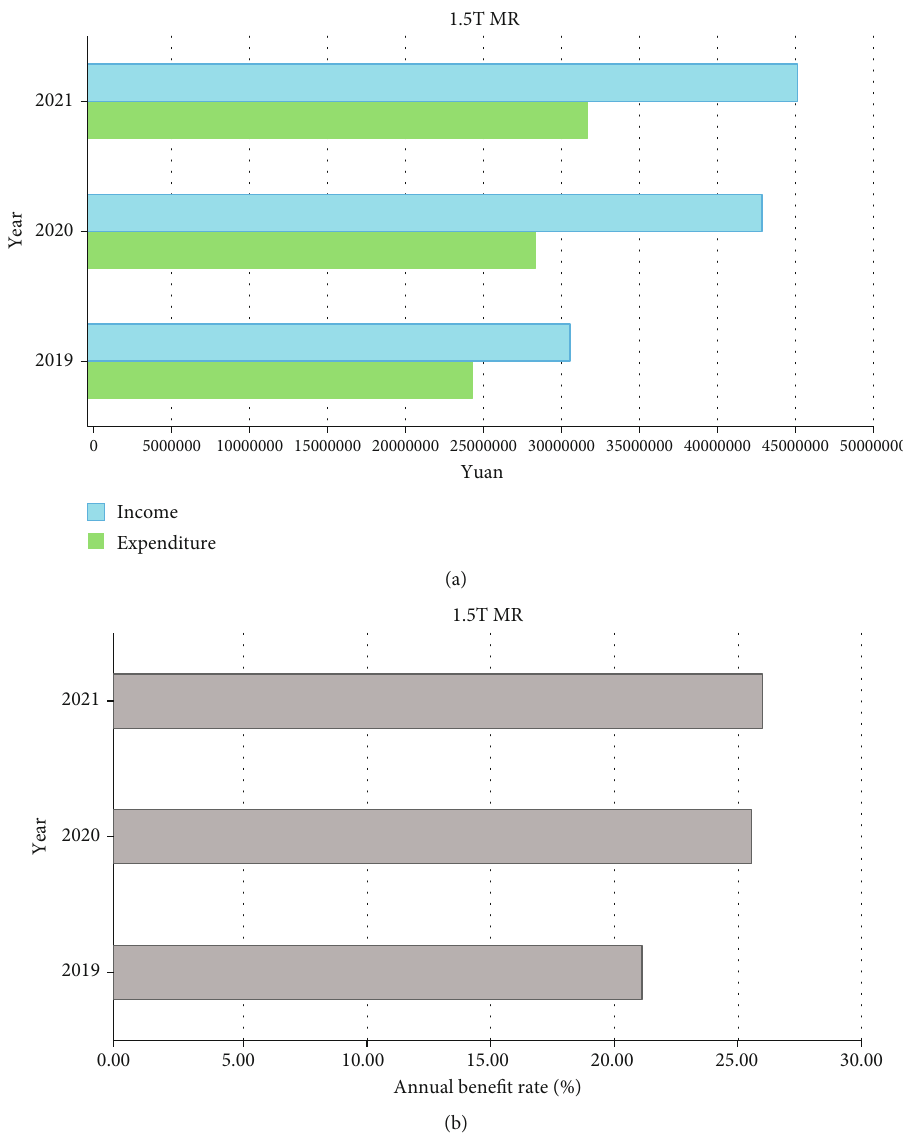
Figure 3: Analysis of operation cost of Optima MR 360W (1.5T MR). (a) The annual income and expenditure of Optima MR 360 W (1.5 T MR) from 2019 to 2021. (b) The annual bene fi t rate of Optima MR 360 W (1.5 T MR) from 2019 to